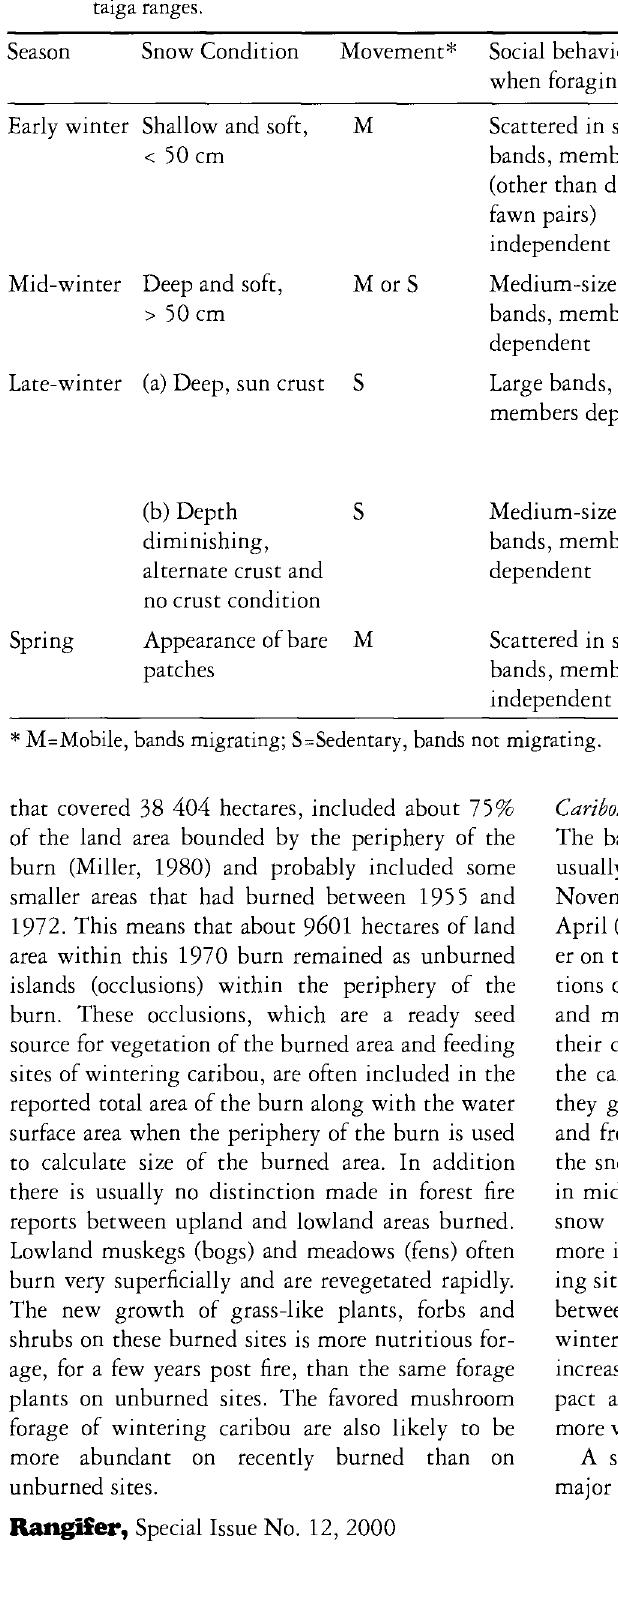
Table 3. General caribou behavior and forage use relationships correlated with periodic changes in the snow cover on taiga